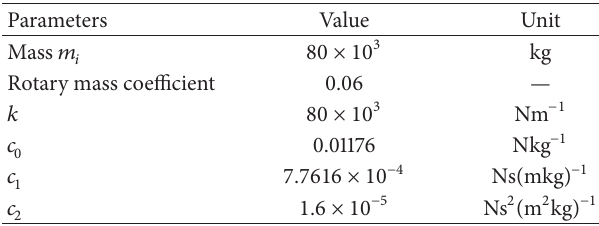
Table 1: The simulation parameters of high speed train. Parameters Value Unit Mass 𝑚 𝑖 80 × 10 3 Rotary mass coefficient 0.06